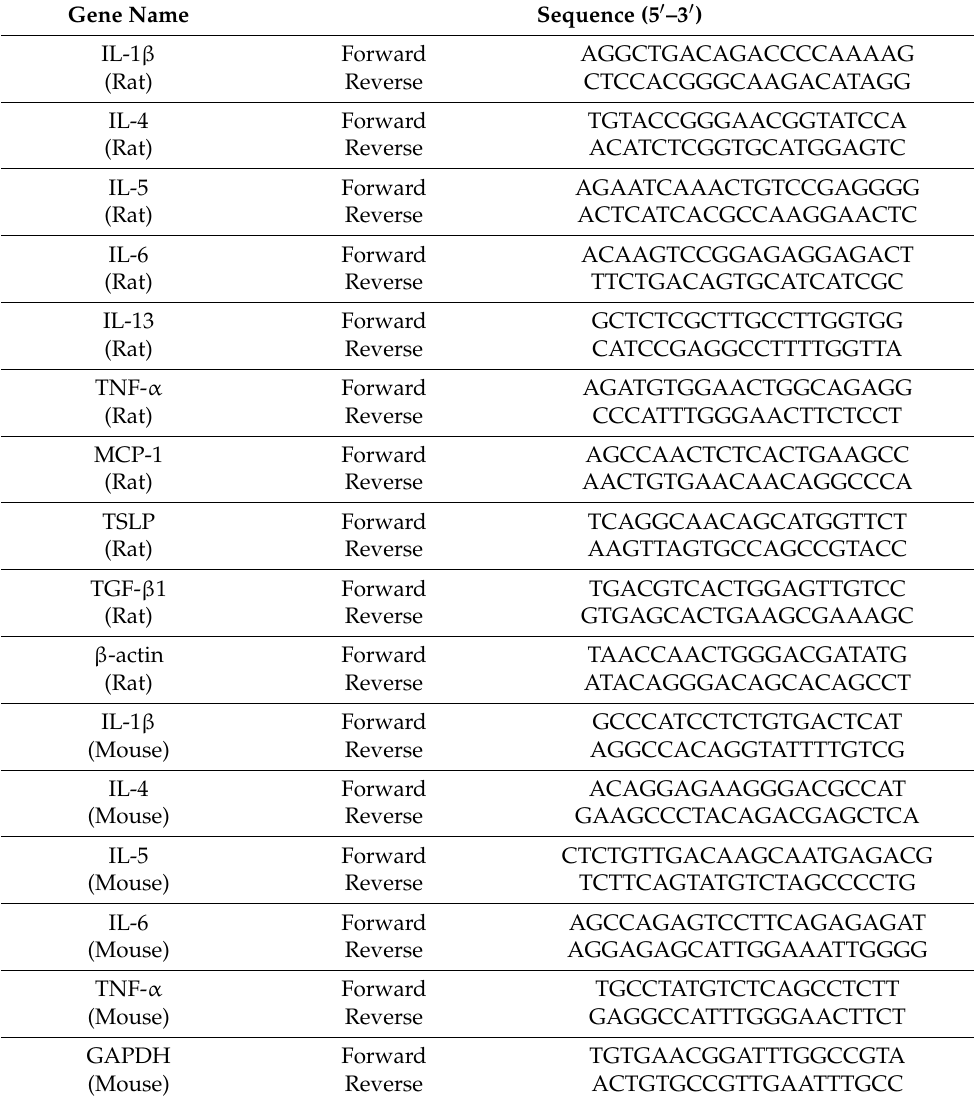
Table 3. Sequences of primers used for